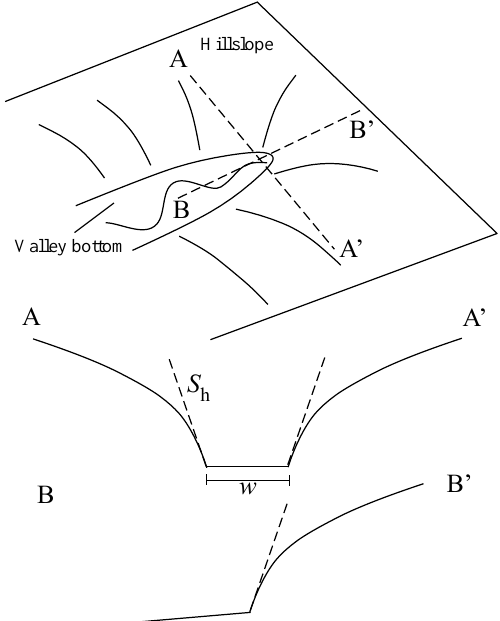
Figure 5. Schematic figure of a valley head. The profile shown along A–A’ is the cross section of the valley head where colluvial sediment flux from hillslopes of mean gradient S h enter a segment of width w . The profile shown along B–B’ is the along-valley pro- file where colluvial sediment flux from just one hillslope enters the valley bottom. The requirement that fluvial erosion rates must be greater than colluvial deposition rates at the valley head provides a quantitative criterion for predicting the drainage density of land- scapes.